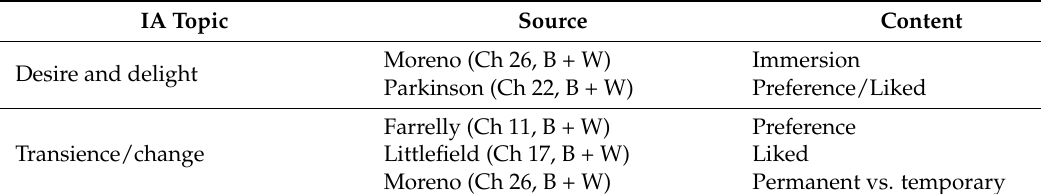
Table 4. Selected preliminary content analysis of selected key texts—user